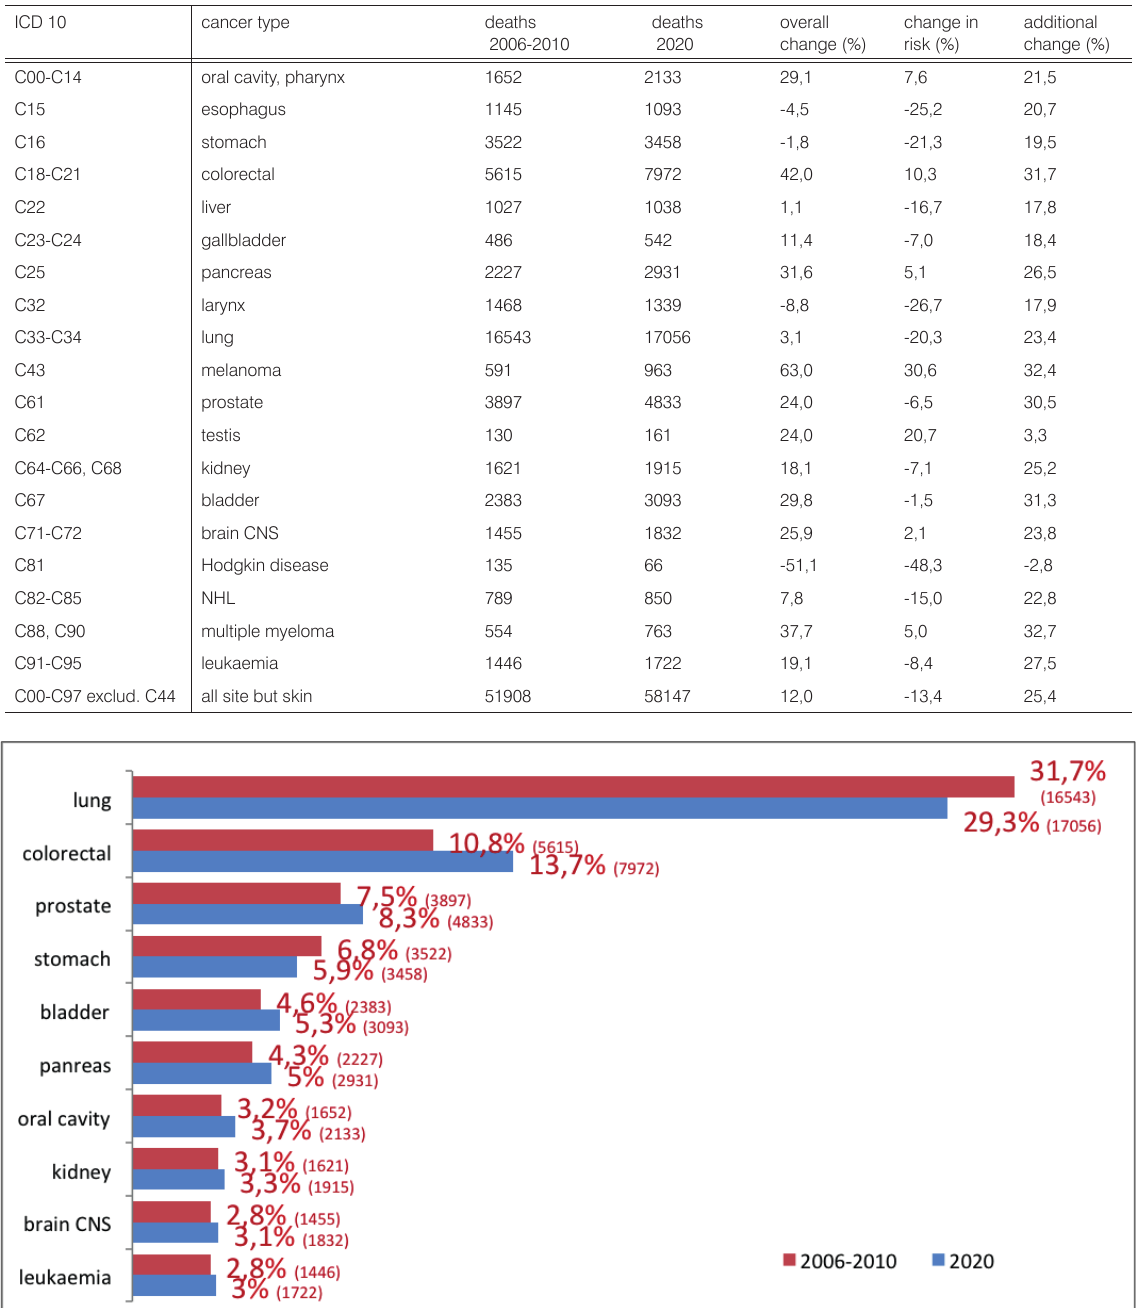
Table 1 . Mean annual number of cancer deaths as observed in 2006-2010 in Poland and predicted for 2020 by site, males. Corresponding percentage change in mortality, decomposed into changing risk and additional change.